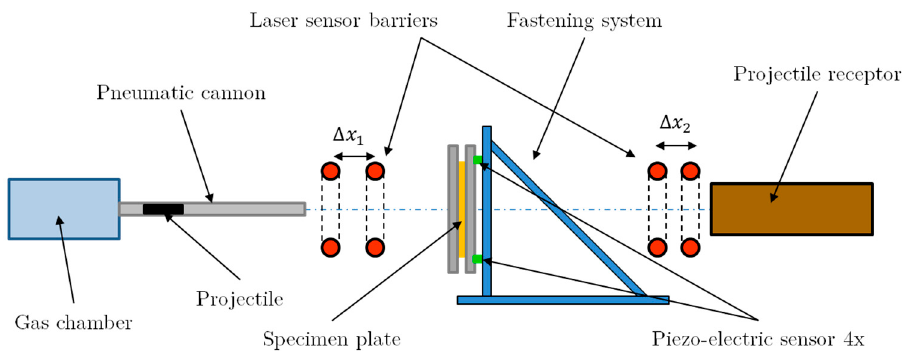
Figure 2. Experimental impact setup description.